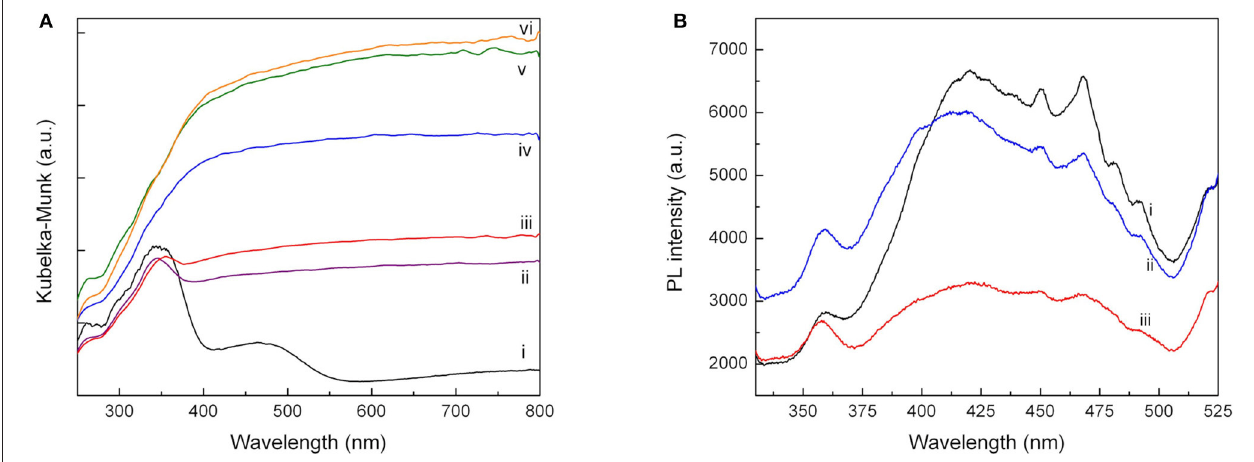
FIGURE 5 | (A) Diffuse reflectance UV-Vis spectra of Pd-Cu-loaded TiO 2 (i); 5CNT-TiO 2 (ii); 10CNT-TiO 2 (iii); 20CNT-TiO 2 (iv); 50CNT-TiO 2 (v); CNT (vi); (B) PL spectra of neat TiO 2 (i), Pd-Cu/TiO 2 (ii) and Pd-Cu/20CN-TiO 2 (iii).